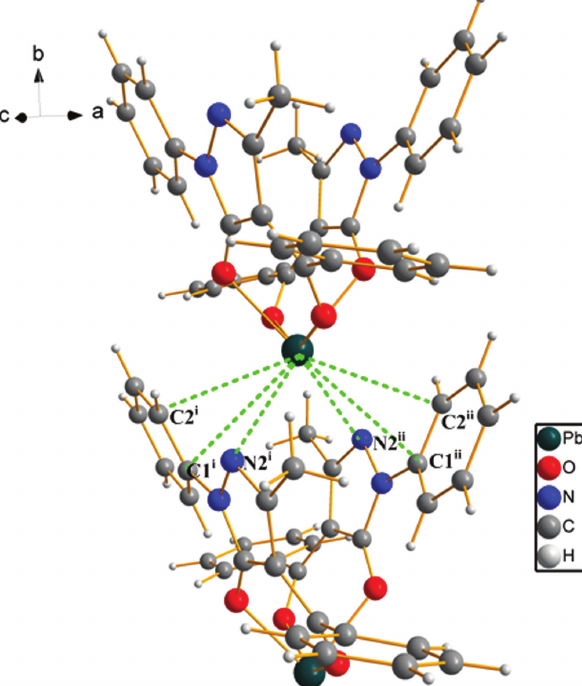
Figure 5 Intermolecular longer secondary Pb···X (X = C or N) interac- tions shown as green dashed